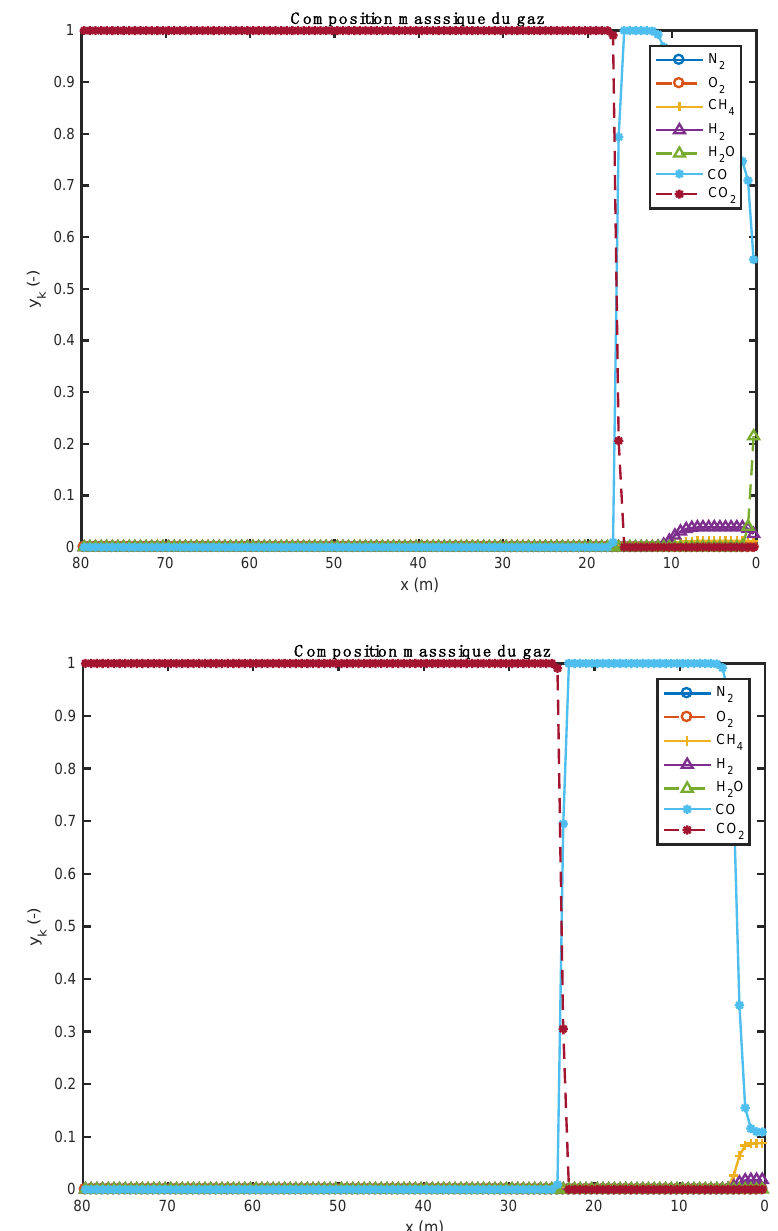
Figure 2. Comparison of gas composition profiles obtained with two alternative fuels (above: biomass; below: tires).